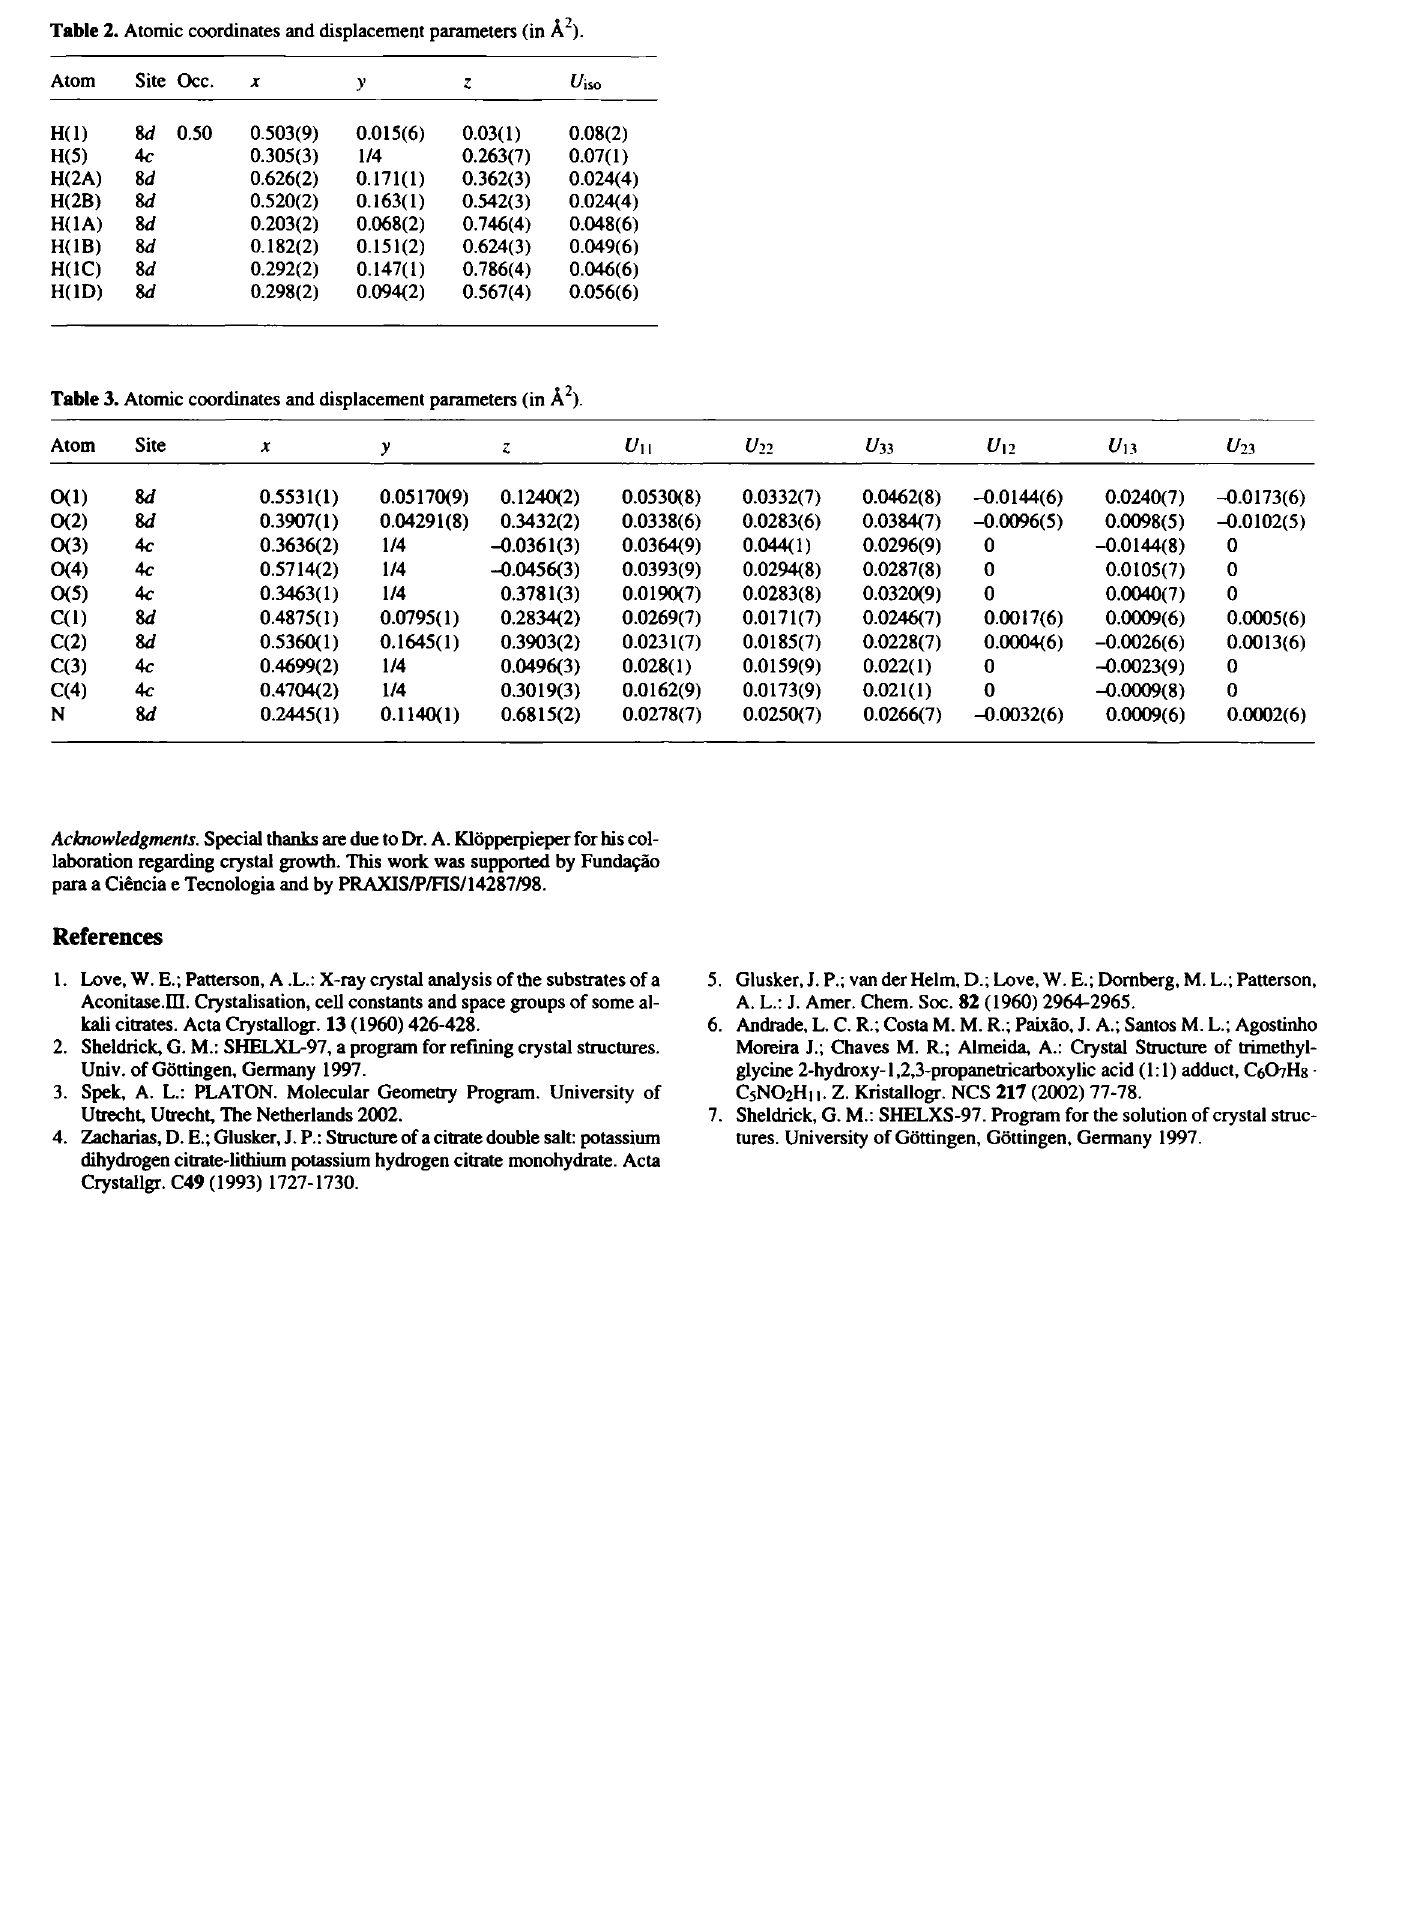
Table 3. Atomic coordinates and displacement parameters (in Â 2